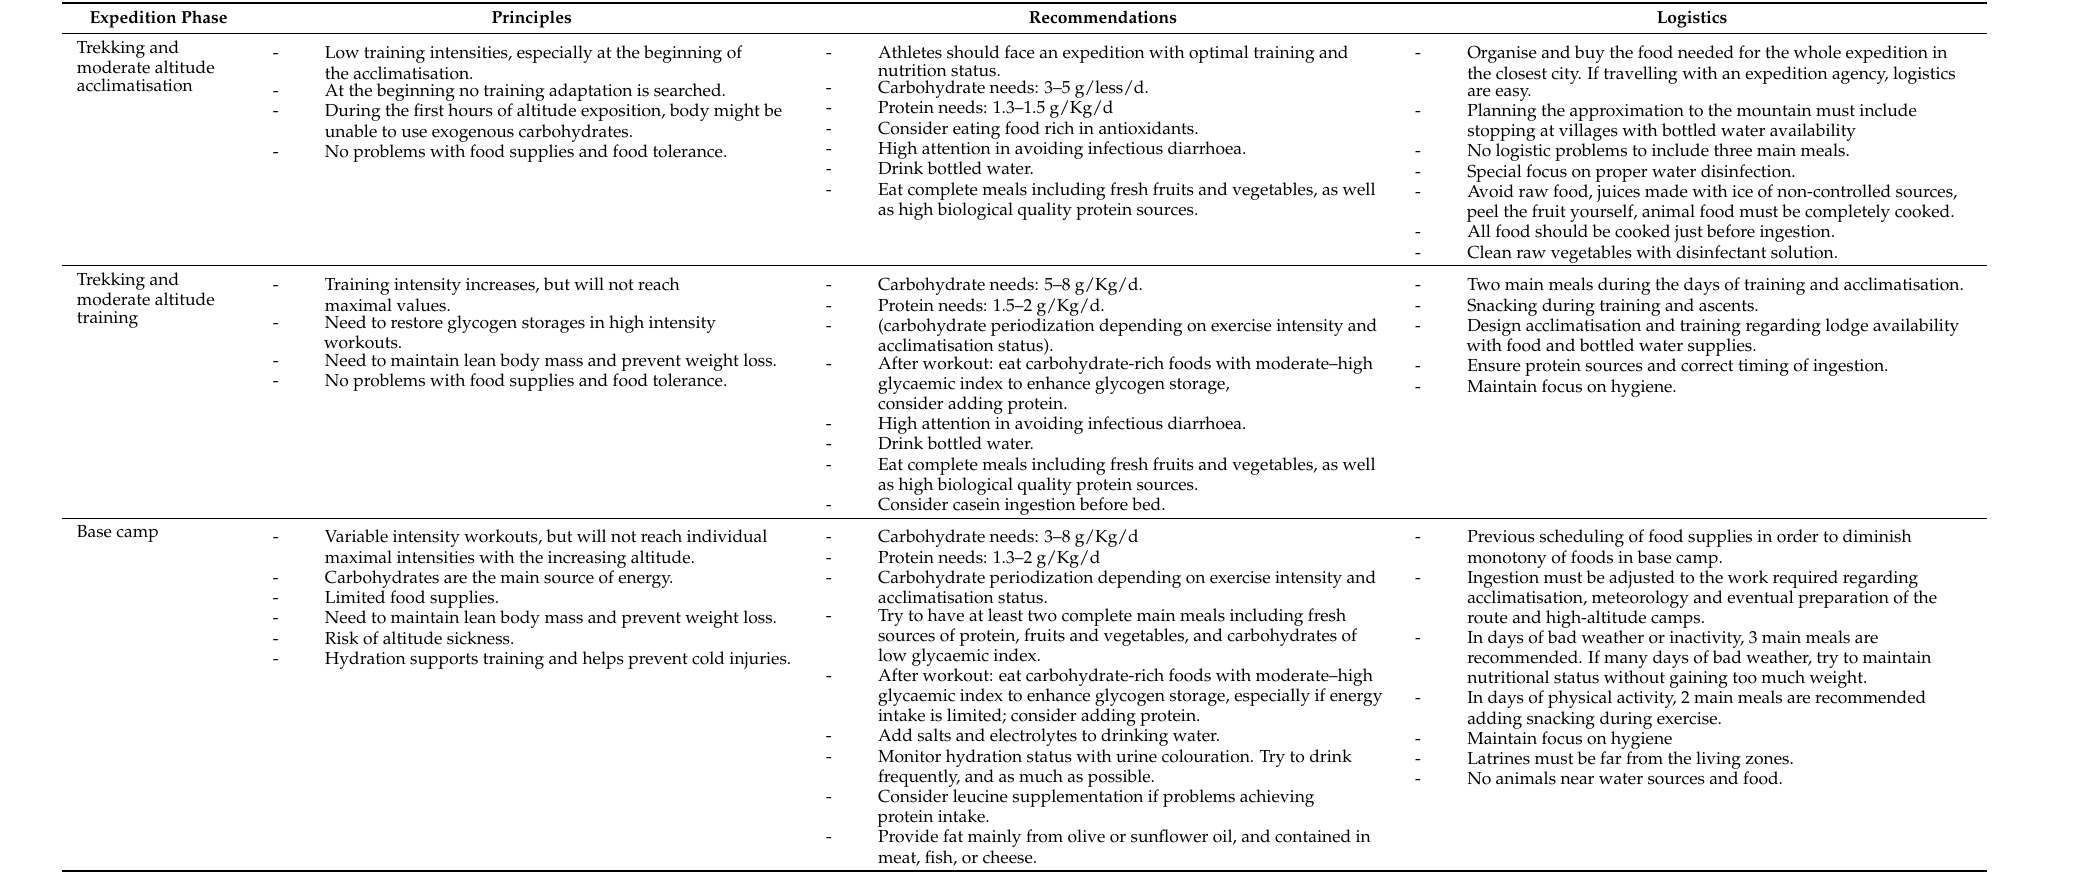
Table 5. The nutritional recommendations for the different expedition